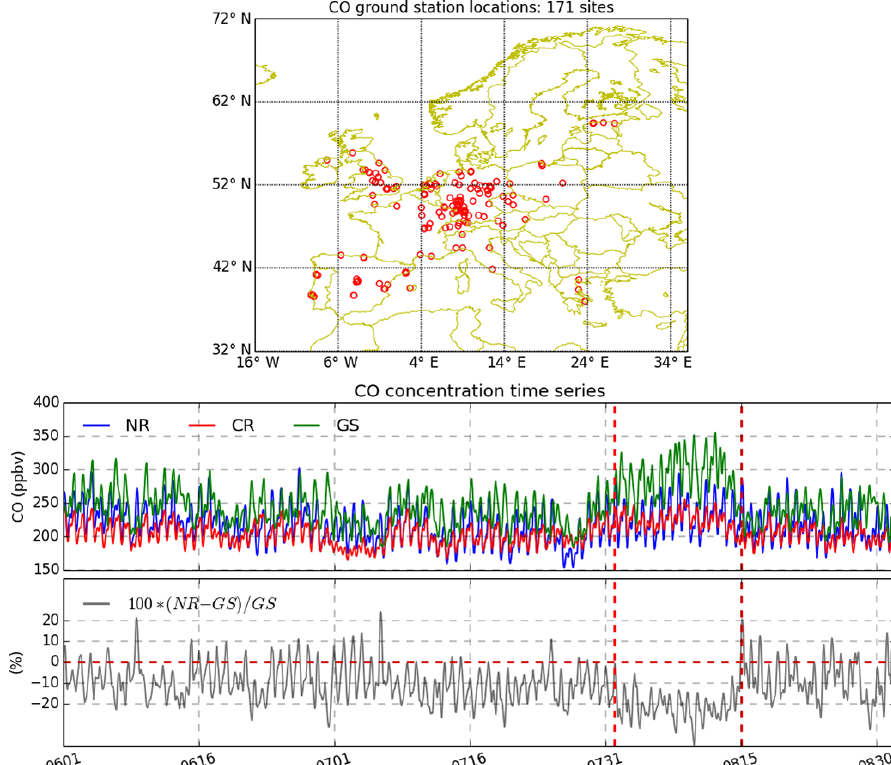
Figure 2. Top panel: location of selected ground-based stations for CO measurements taken from the AirBase database during northern summer 2003 (1 June–31 August). There are 171 sites with locations shown by circles. The labels show longitude in degrees ( x axis) by latitude in degrees ( y axis). Middle panel: simulated and measured time series of CO concentrations in surface air from nature run (blue line), the control run (red line), and the selected 171 AirBase sites (green line). We form the CO time series for the ground-based stations by averaging the hourly data representative of the 171 sites. The labels show time in MMDD format ( x axis) by CO concentration in parts per billion by volume, ppbv ( y axis). Bottom panel: the grey curve shows the relative error of the nature run (NR) with respect to the observations, defined as NR value minus ground station value divided by the ground station value and multiplied by 100. The labels show time in MMDD format ( x axis) by relative error in percent ( y axis). The vertical red dashed lines in the middle and bottom panels delineate the 2003 European heat wave period (31 July–15